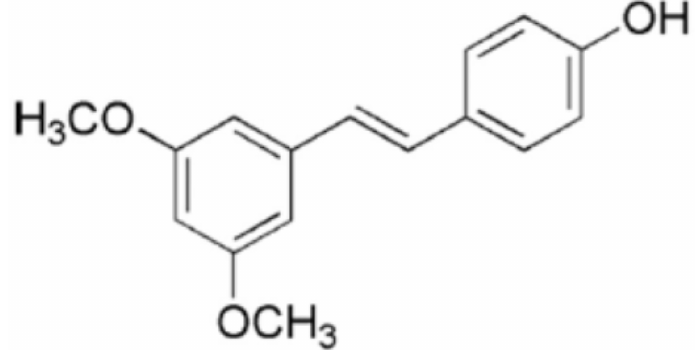
Figure 1. Chemical structure of pterostilbene